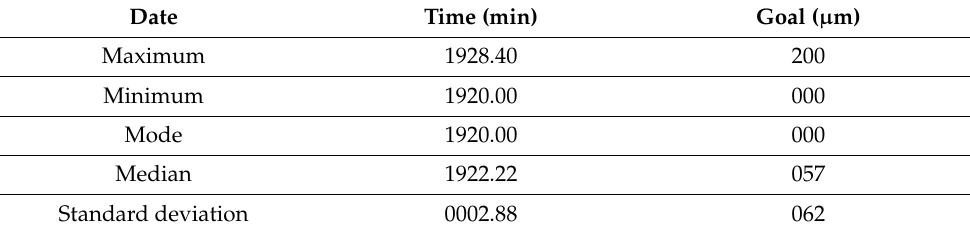
Table 5. Time and goal